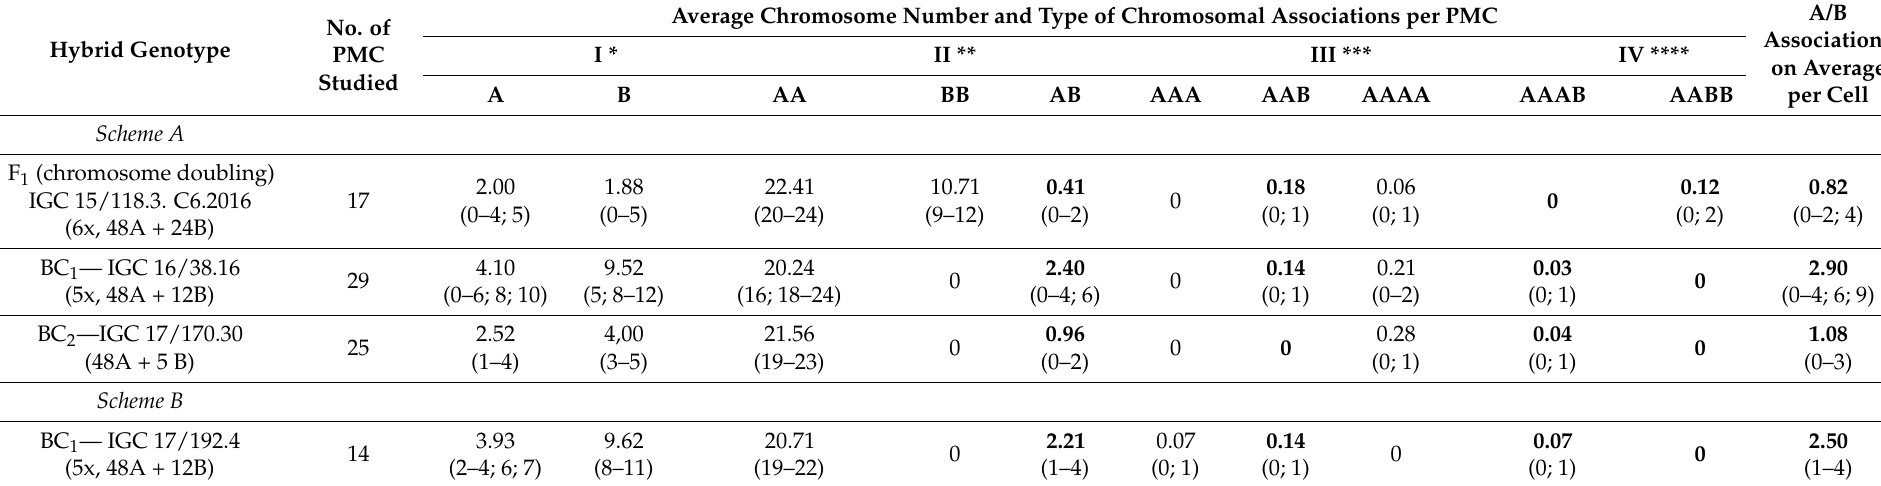
Table 2. Mean chromosome pairing at diakinesis in selected hybrid genotypes analyzed by